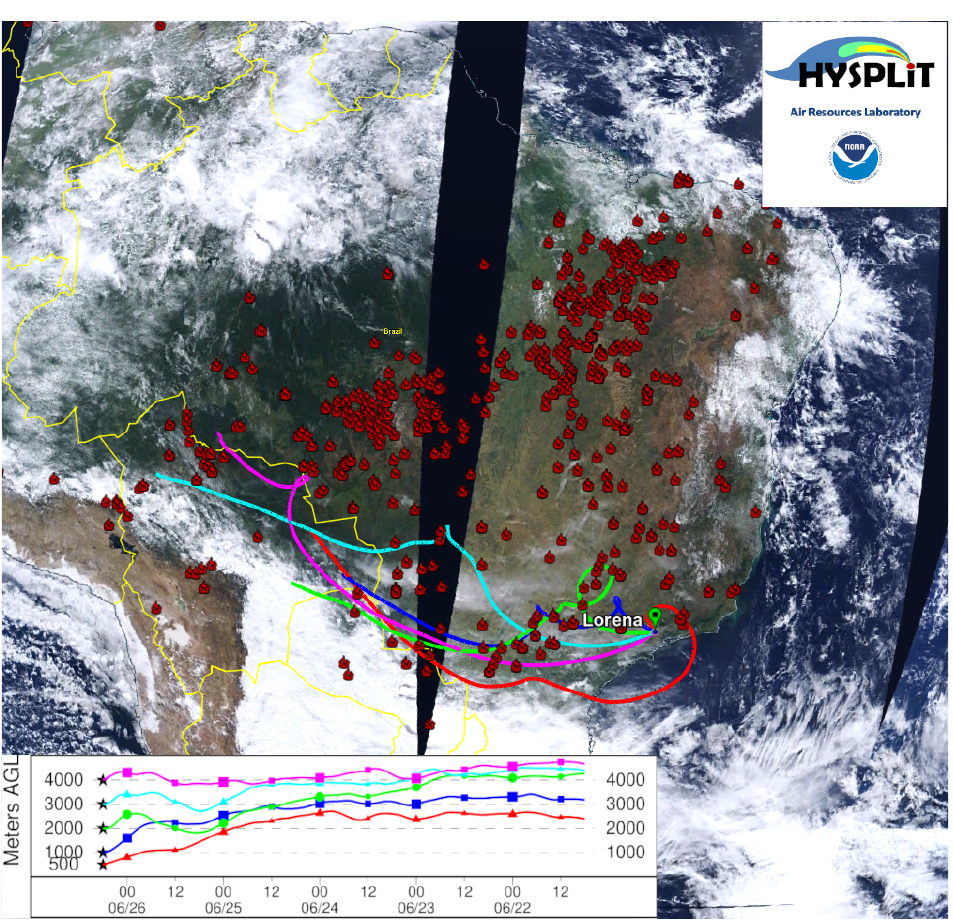
Figure 7. Five-day backward trajectories ending at Lorena site with different altitude levels, from 500 to 4000 m a.g.l., on 26 June 2014 at 06:00 UTC. Several fire focuses, represented by the red points, are detected by AQUA MODIS monitoring and retrieved from the biomass burning database from The National Institute for Space Research (INPE)—http://queimadas.dgi.inpe.br/queimadas/portal (accessed on 17 September